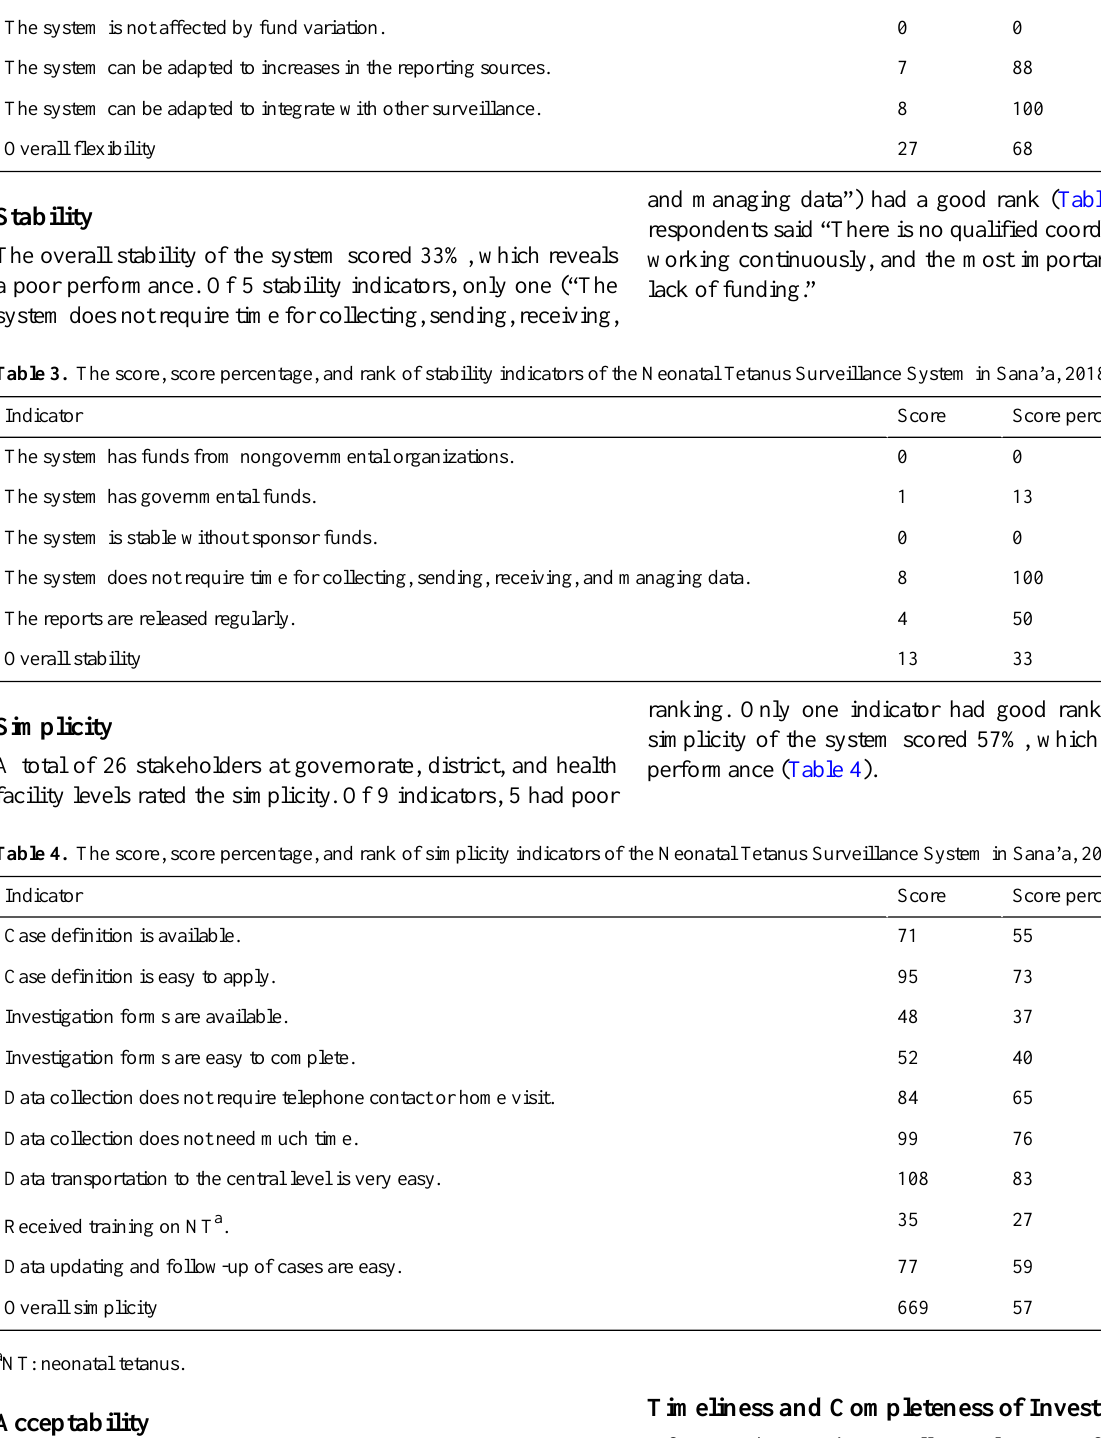
RankScore percentageScoreIndicator